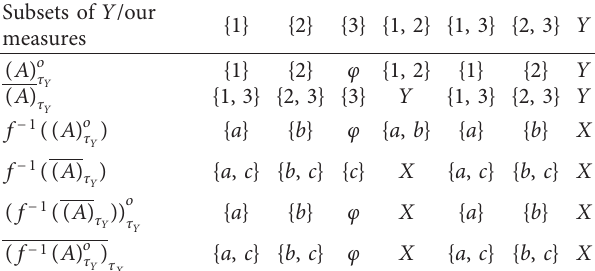
Table 1: Calculations of topological rough continuous